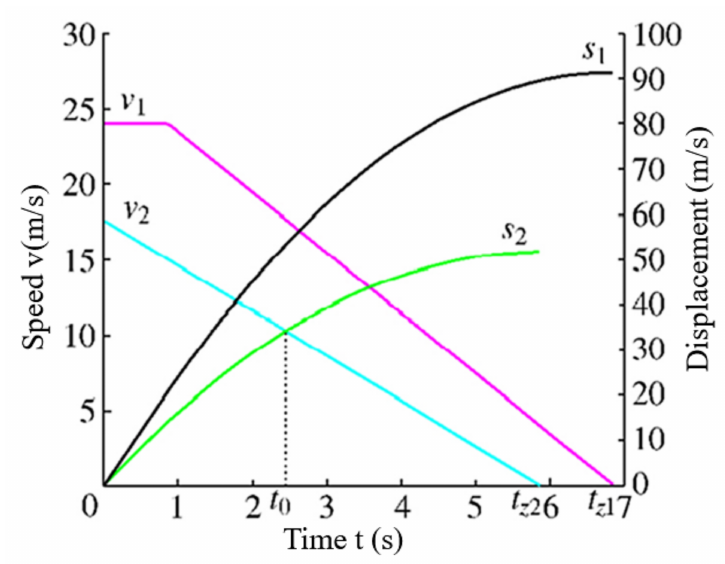
Figure 16. Velocity—displacement variation